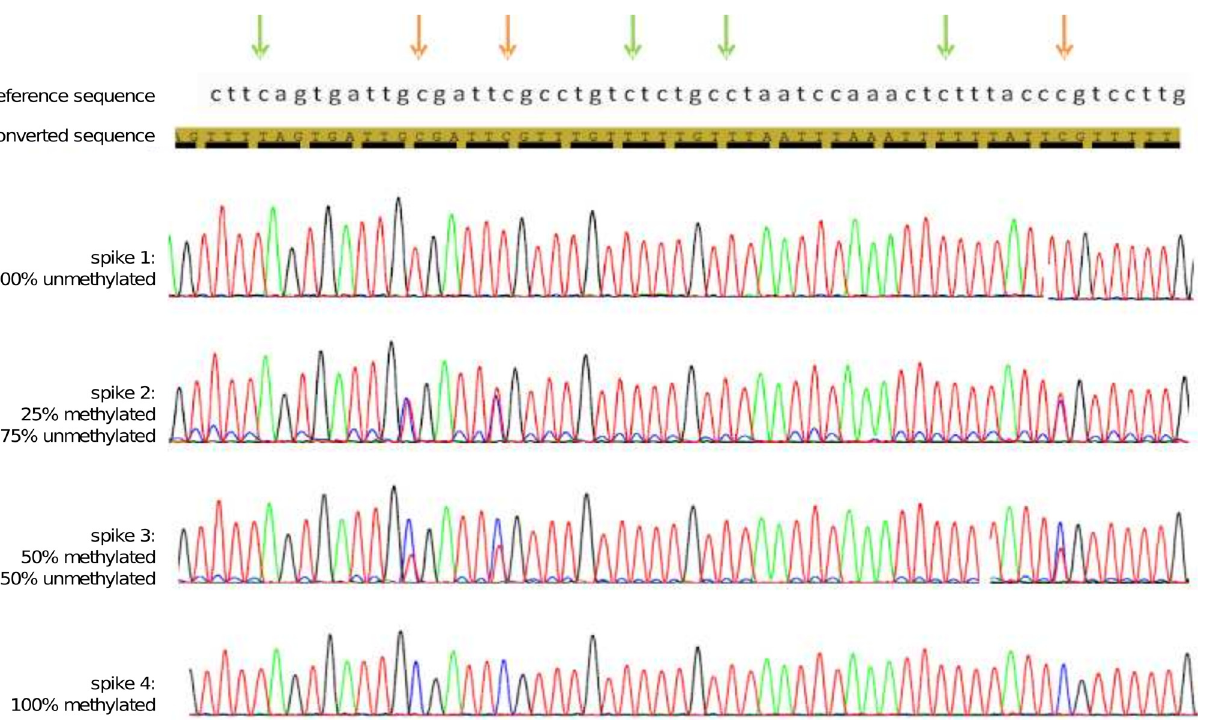
Fig 2. Bisulfite sanger sequencing of the λ -DNA methylation controls. A section of the sequencing trace for all spikes is presented. The reference sequence and the in-silico converted sequences are shown on top. Green arrows indicate non-CpG cytosines (blue) that are all converted to thymines (red) in all spikes. Orange arrows indicate CpG cytosines that are fully converted in spike 1, partially converted in spikes 2 and 3 and not converted in spike 4.